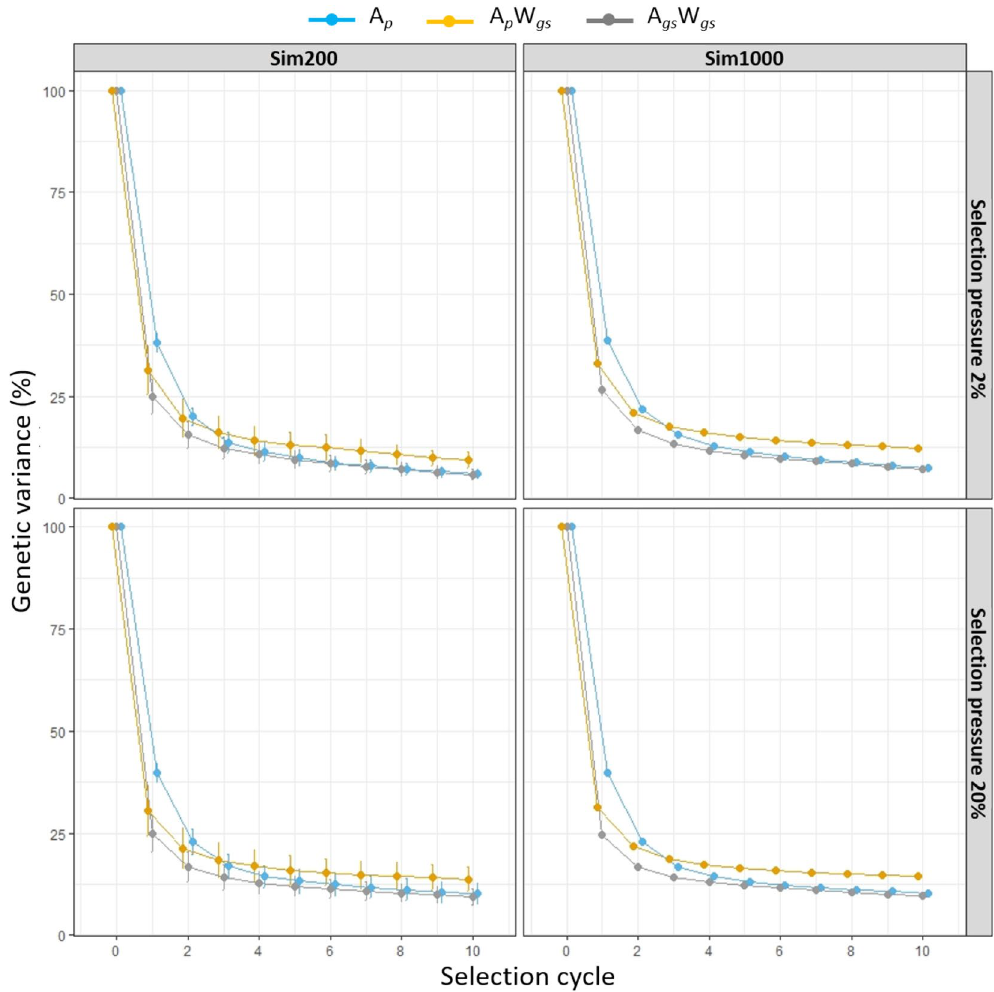
Figure 4. The percentage of genetic variance at each selection cycles estimated in Sim200 and Sim1000 training populations using three breeding strategies (A p , A p W gs and A gs W gs ). A selection pressure of 20% and 2% was imposed to select best half-sib families and within each family, for the A p W gs and A gs W gs strategies top 5 and 50 individuals were selected and for A p strategy random 5 and 50 individuals were selected to restore the initial number of parents for next selection cycle. In each selection cycle percentage genetic variance was based on 250